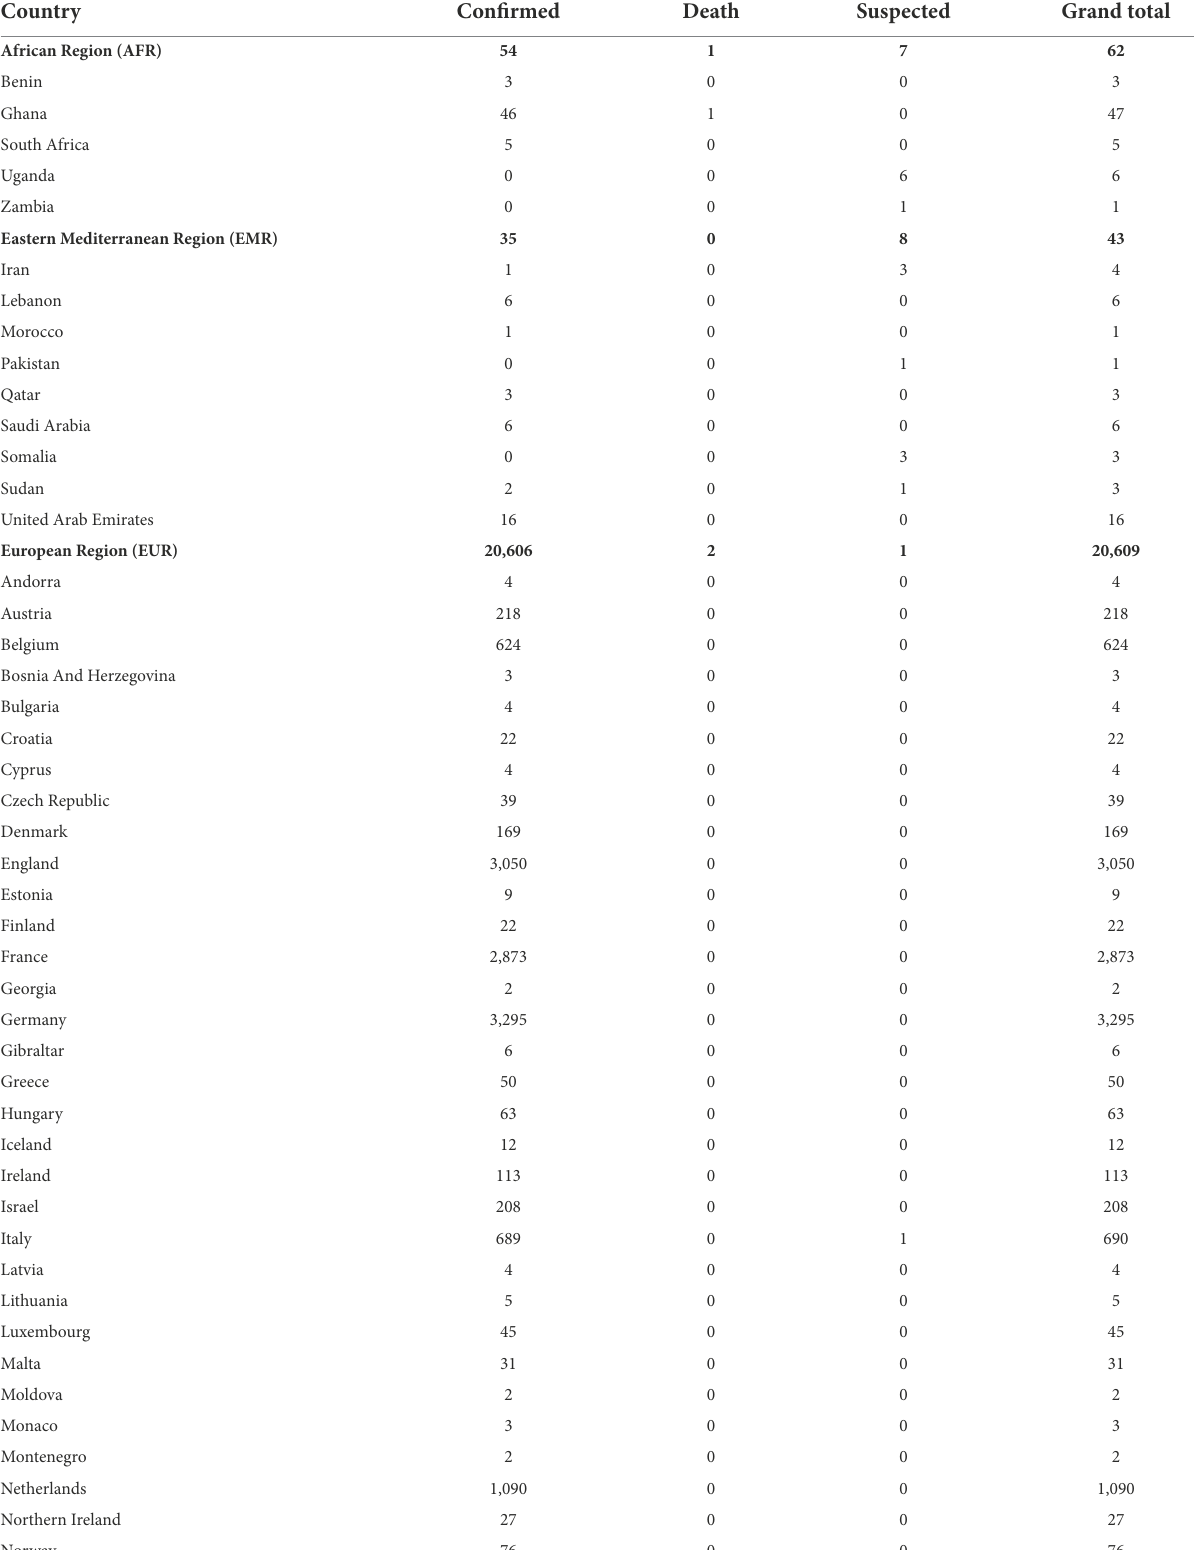
TABLE 1 Monkeypox cases (confirmed and suspected cases, deaths, and grand total) broken down according to the World Health Organization (WHO) region, and country. Country Confirmed Death African Region